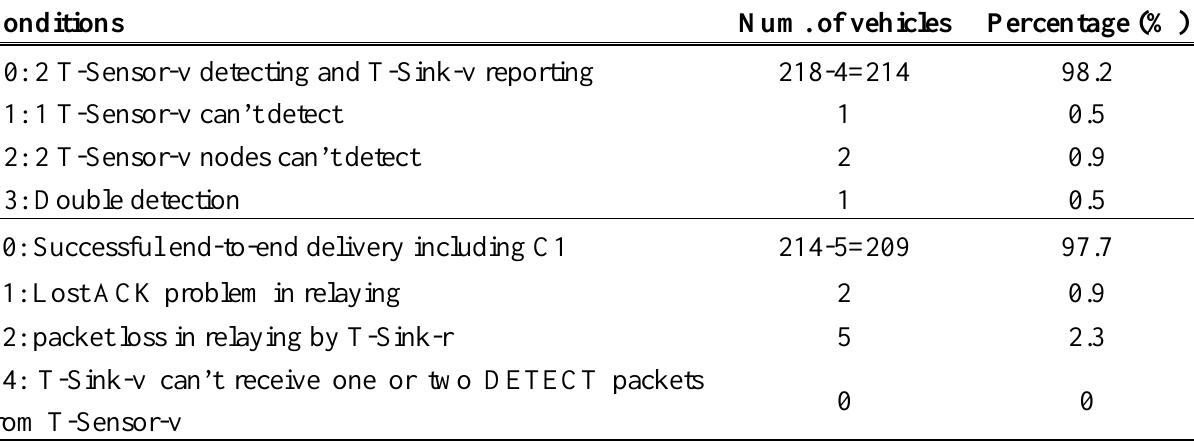
Table 2. ICC gate testbed test results. 98.2% of vehicles were detected by two T-Sensor-v nodes and 97.7% among them is delivered to the T-BS-com-v